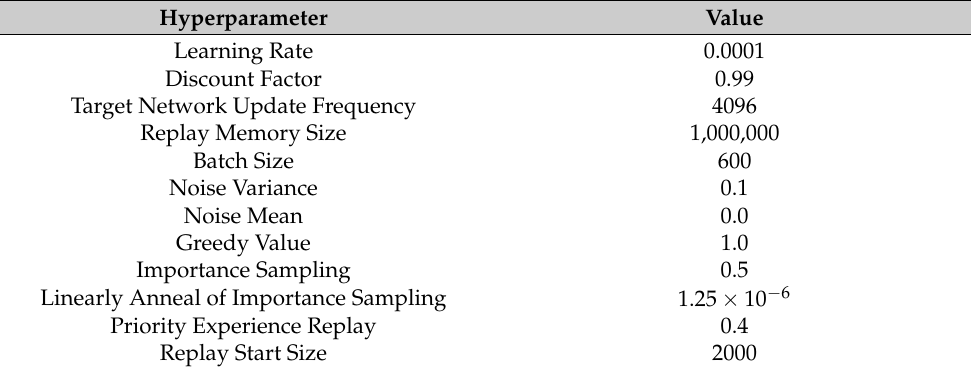
Table 1. Hyperparameters for